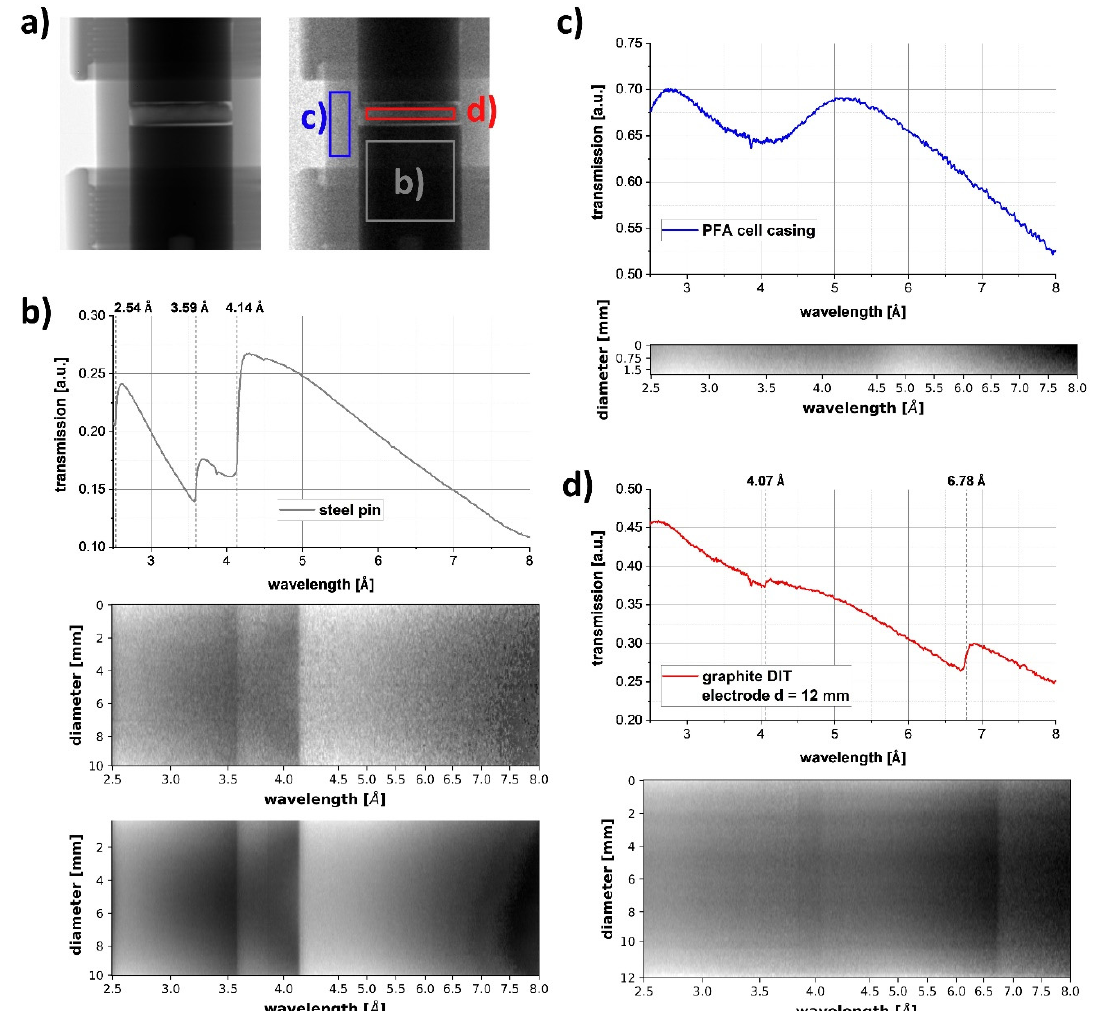
Figure 3. Bragg edge transmission radiography of the 12 mm diameter DIT graphite electrode inside a 1 / 2” Swagelok cell. ( a ) Polychromatic neutron radiograph (left) and a monochromatic radiograph at 2.6 Å (right). Coloured boxes mark regions of interest for the transmission curves for the steel pin ( b ), the PFA region ( c ), and the electrode ( + PFA housing) ( d ). Corresponding wavelength-resolved transmissions for a single pixel row and for summed-up transmissions over multiple rows are displayed for the same regions of interest.